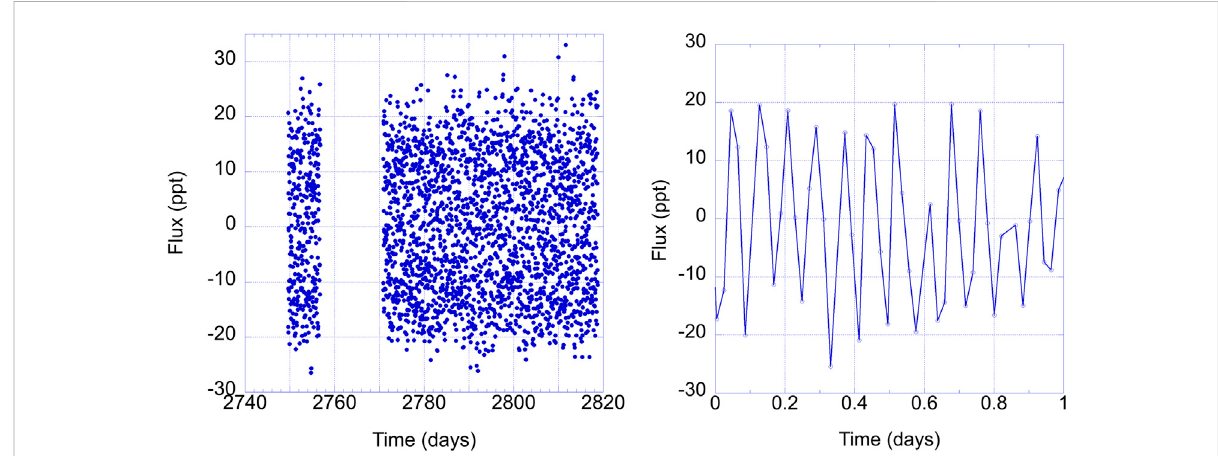
FIGURE 1 Left: FG Vir K2 30-min cadence light curve from Campaign 10, showing 52.5 days of data, excluding the gap near the beginning of the data set. Time is measured after barycentric Julian day 2454833.0. Right: Zoom-in on FG Vir K2 light curve on day